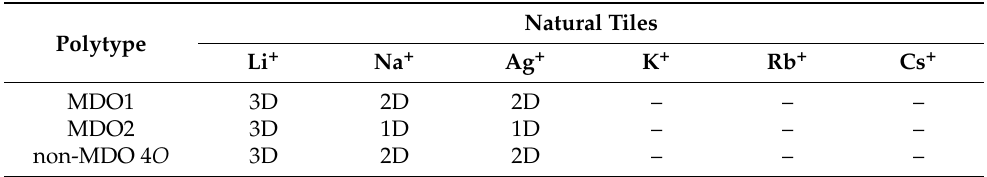
Table 2. The natural tiles in the MT -frameworks of the polytypes of compounds with the general